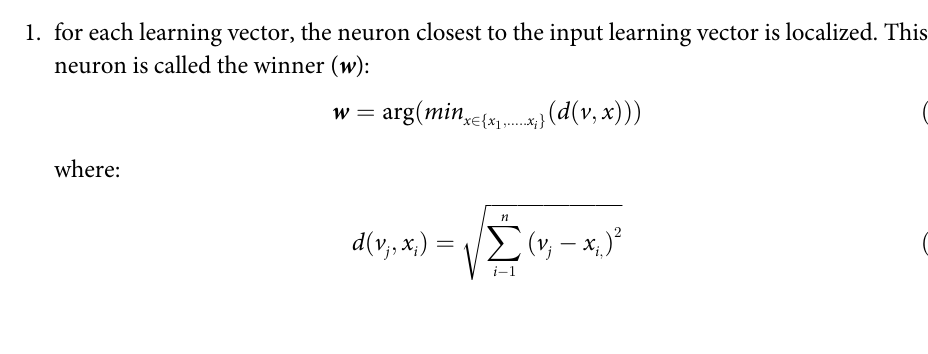
ffiffiffiffiffiffiffiffiffiffiffiffiffiffiffiffiffiffiffiffiffiffiffiffiffiffiffi X n